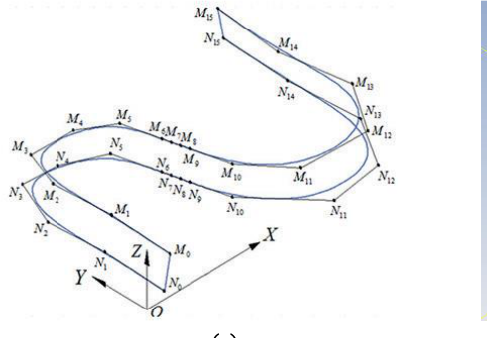
Figure 1. Proposed S-shaped workpiece for ISO standard, reproduced with permission from [14].